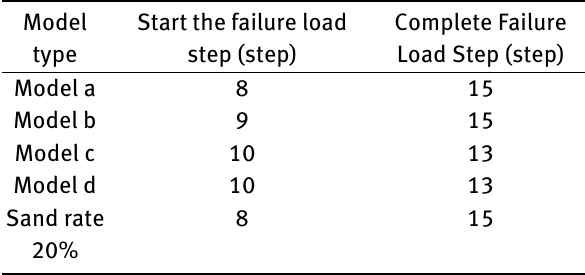
Table 4: Analysis of failure of specimens